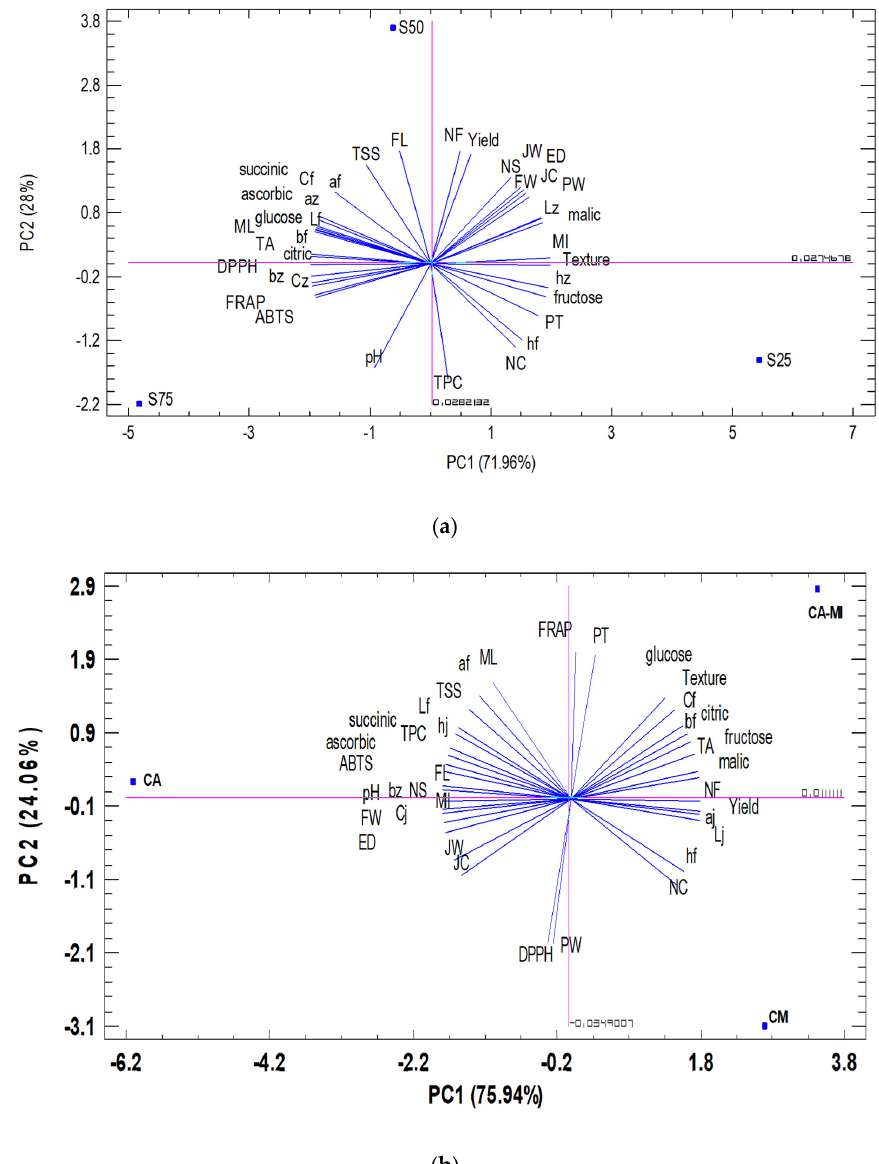
Figure 2. Principal component analysis of the morphological characteristics and chemical parameters evaluated in ‘Verna’ lemons depending on the ( a ) substrate where S25, S50, and S75 represent the content in the marine sediment substrate—being 25%, 50%, and 75%, respectively; and ( b ) rootstock used, where CM, CA-MI, and CA represent the Citrus macrophylla rootstock. Citrus aurantium/Citrus sinensis , and Citrus aurantium , respectively.